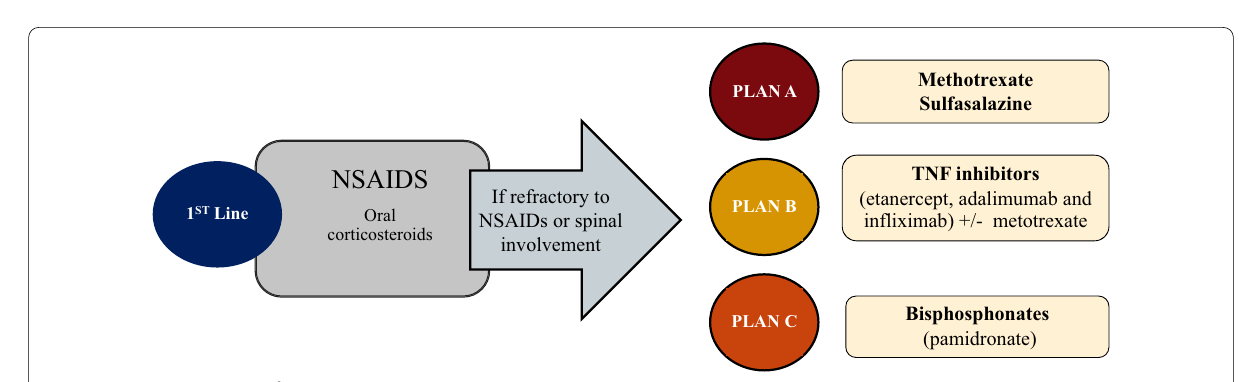
Fig. 14 Treatment options of